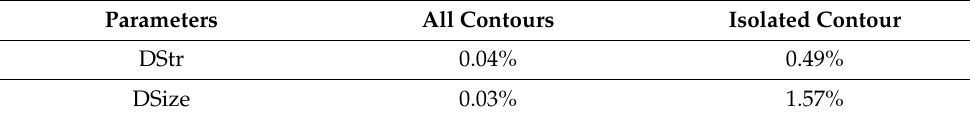
Figure 13. Bathymetric contour map of the lake. Credit: Map created by April Behr [40]. Alaska Department of Fish and Game. Table 1. Changes of morphological characteristics of the contour map and isolated